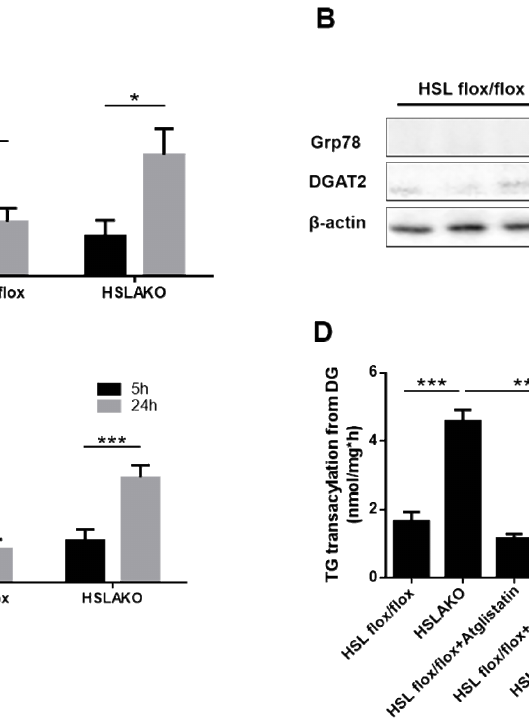
Figure 2. Levels of 3 H-TG transacylation from 3 H-DGs. ( A ) Levels of 3 H-TG transacylation from 3 H-DGs in WAT cytosol from 5-h and 24-h fasted mice. ( B ) Levels of DGAT2 and ER marker Grp78 protein in the isolated lipid droplet (LD) fraction of HSL flox/flox and HSLAKO mice were measured by Western blotting. Positive control means cytosolic protein from HSL flox/flox mice. ( C ) Levels of